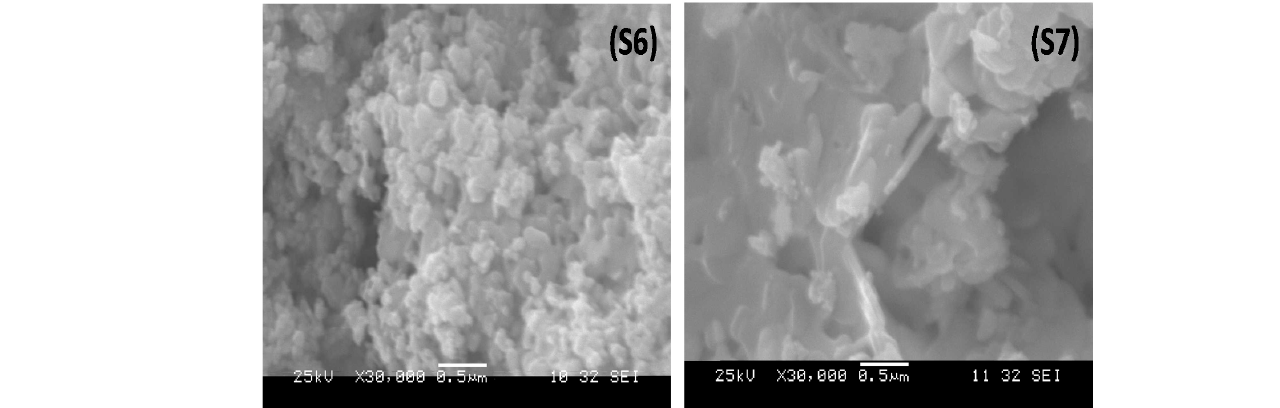
Figure 2. SEM pictures of the synthesized La 2 O 3 –ZnO nanocomposites at various concentrations. Table 2. A comparison of the XRD-derived crystallite size, dislocation density, and lattice strain.